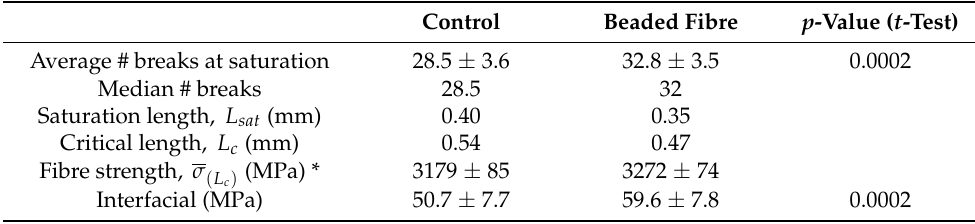
Table 1. Effective interfacial shear strength.